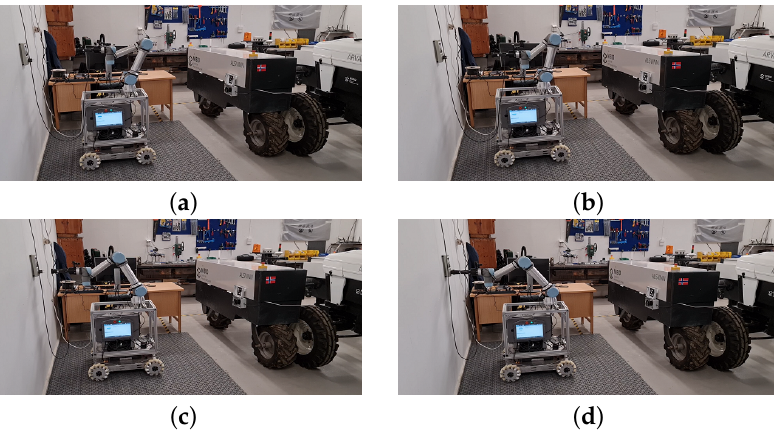
Figure 16. Sequence 5: Plug the cable back into the wall-plug. ( a ) Seq 5.1: Align the MP to the wall-plug. ( b ) Seq 5.2: Align the gripper to the AEV fiducial marker. ( c ) Seq 5.3: Move the gripper to the approach point. ( d ) Seq 5.4: Plug the cable back to the wall-plug. Once the final sequence is completed, the robot arm goes back to the initial pose, and the ACS goes into an idle mode waiting for a new charging request (Figure 17).